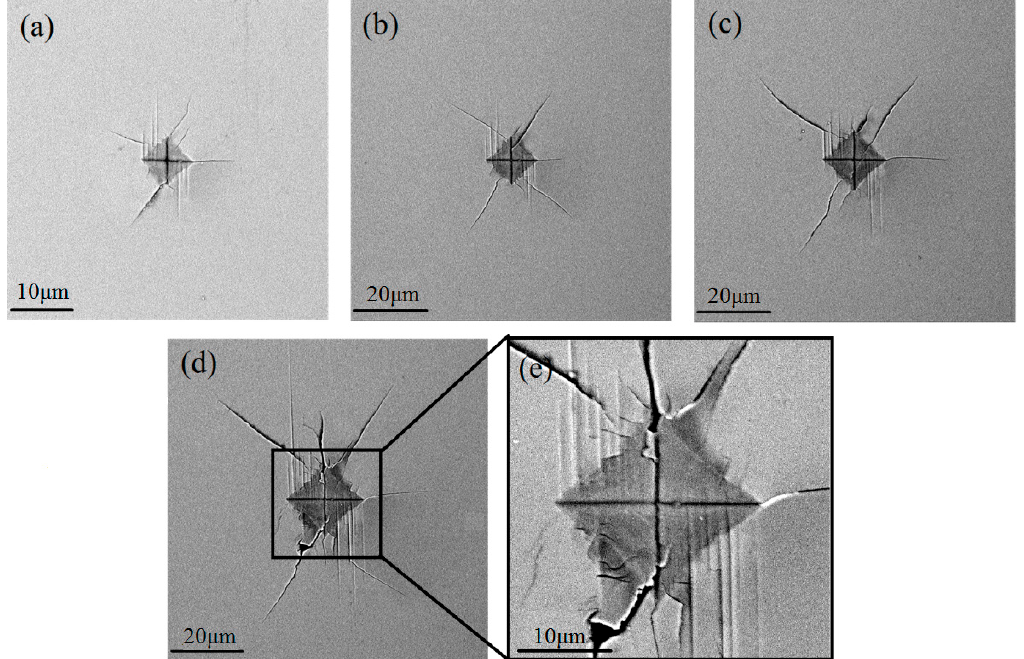
Figure 7. S EM images of A-plane sapphire for ( a ) 2 μ m, ( b ) 4 μ m, ( c ) 6 μ m, and ( d ) 8 μ m depth indentations, and ( e ) the enlarged detail of the selected region in ( d ).